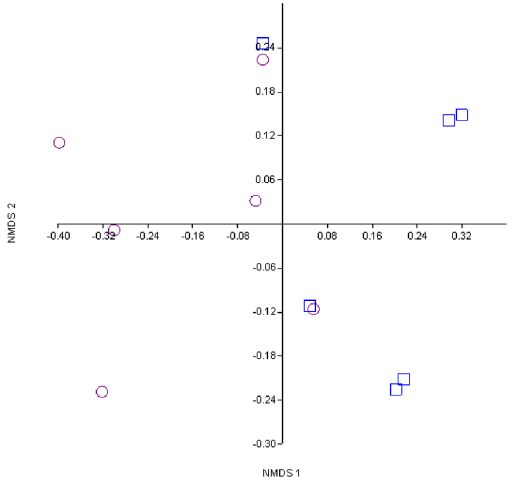
Figure 2. NMDS graphics for the sampling periods based on abundance of trophic categories. □ = flood season and ○ = dry season.